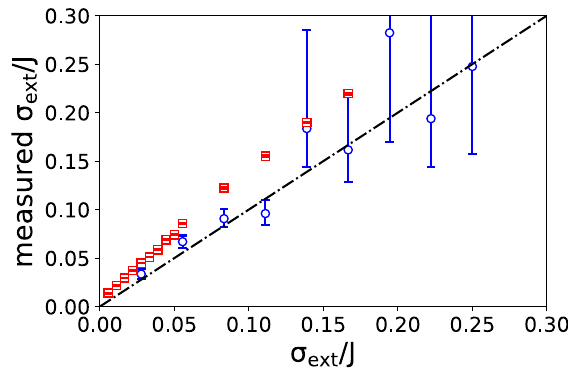
Fig. 9 Plot of measured values of σ ext , where the local random fi elds measured in the absence of the imposed local fi elds σ ext , are subtracted according to the quadrature formula in text, versus its actual value, assuming the system freezes when A ð t Þ ¼ 0 : 1 GHz . The effective random- fi eld strength we have used is the same as ¼ 0 : 24 , so that T = 15 mK ¼ 0 : 31 GHz and J ¼ 1 : 80 GHz , before, σ ζ T ¼ 0 : 041 . Blue circles are from comparing the “ depth ” we obtain σ ζ J of the U with numerical sampling. Red squares are from comparing autocorrelation with the results of numerical sampling. Dot-dashed line is a locus where measured and applied σ ext are equal. For this plot we de fi ne the “ depth ” as the ratio of the probability to fi nd the domain wall in the middle site over the sum of all probabilities excluding terminal sites. The terminal sites are excluded to avoid having to compensate for the background susceptibility effect seen in Fig.